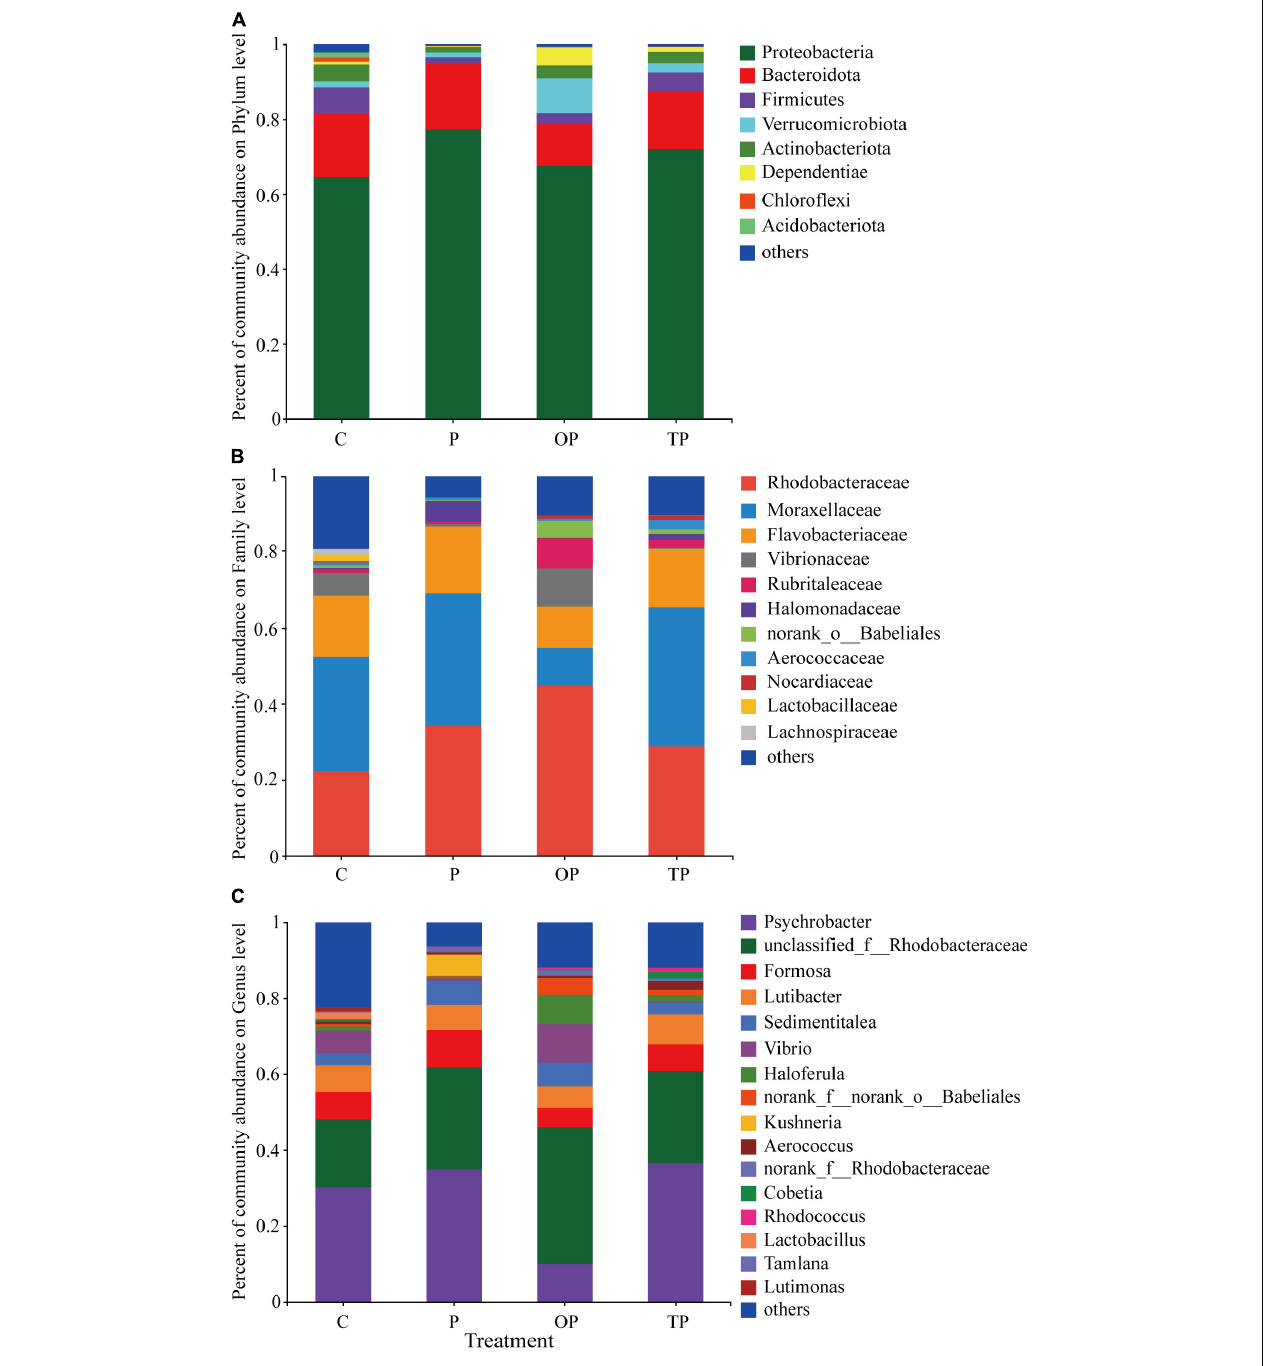
FIGURE 5 | Effects of diet supplementation with different levels of PHB on microbial community composition. (A) At the phylum level, (B) at the family level, and (C) at the genus level. C (control): basal diet; P: basal diet supplementation with 0.5% PHB; OP: basal diet supplementation with 1% PHB; TP: basal diet supplementation with 3%